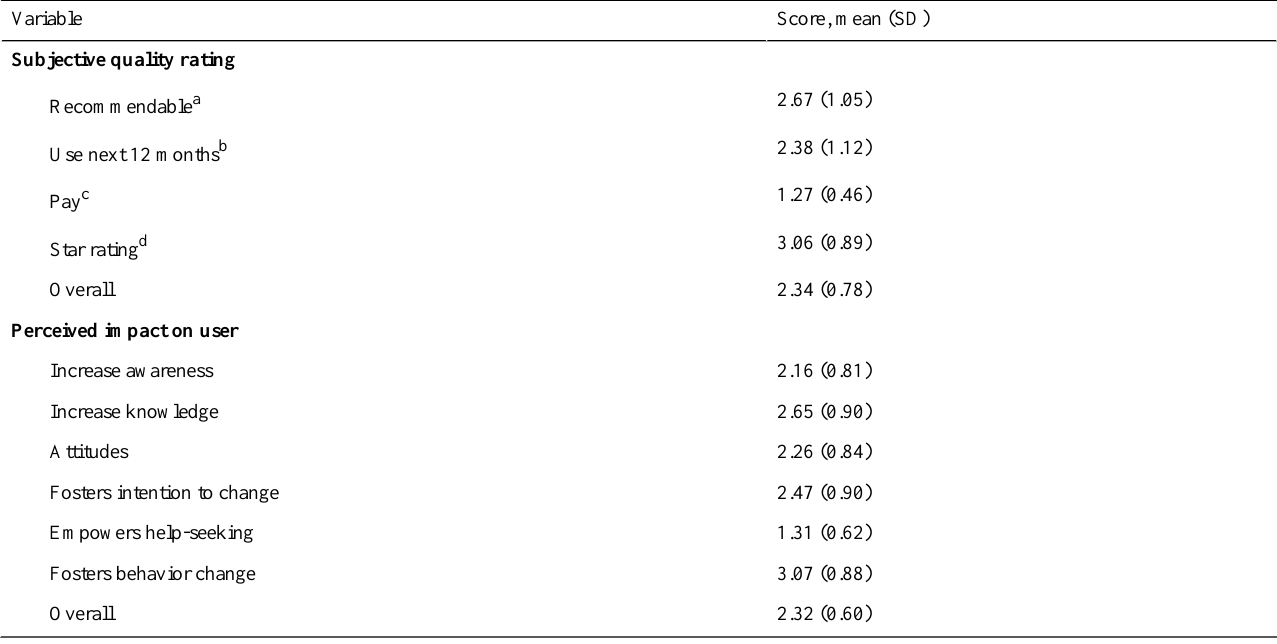
Table 1. Subjective quality ratings and ratings of the perceived impact on the users of mobile app rating